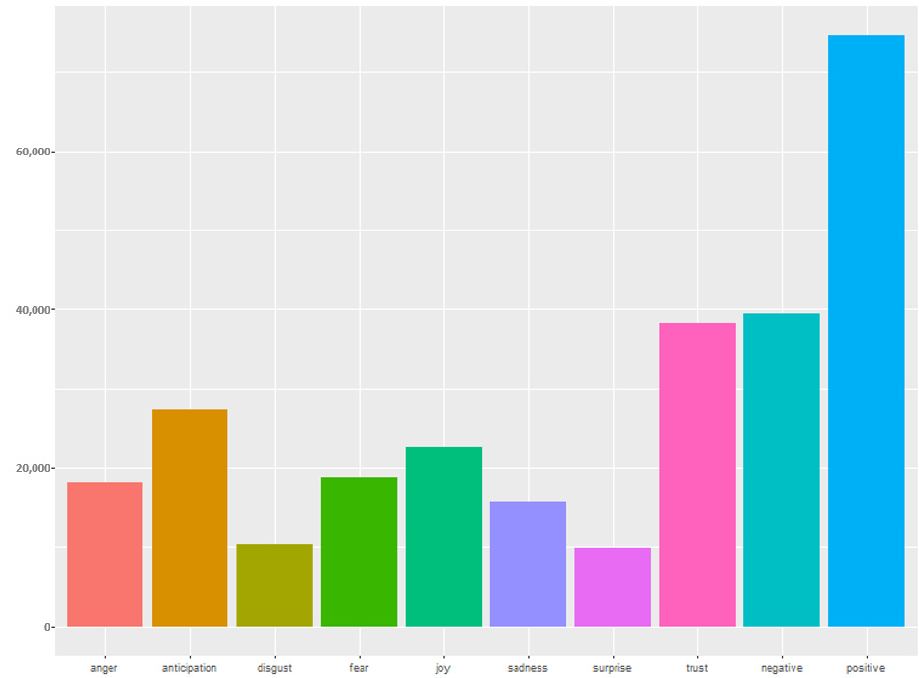
Figure 8. Analysis of sentiments and emotions graph (period 1).